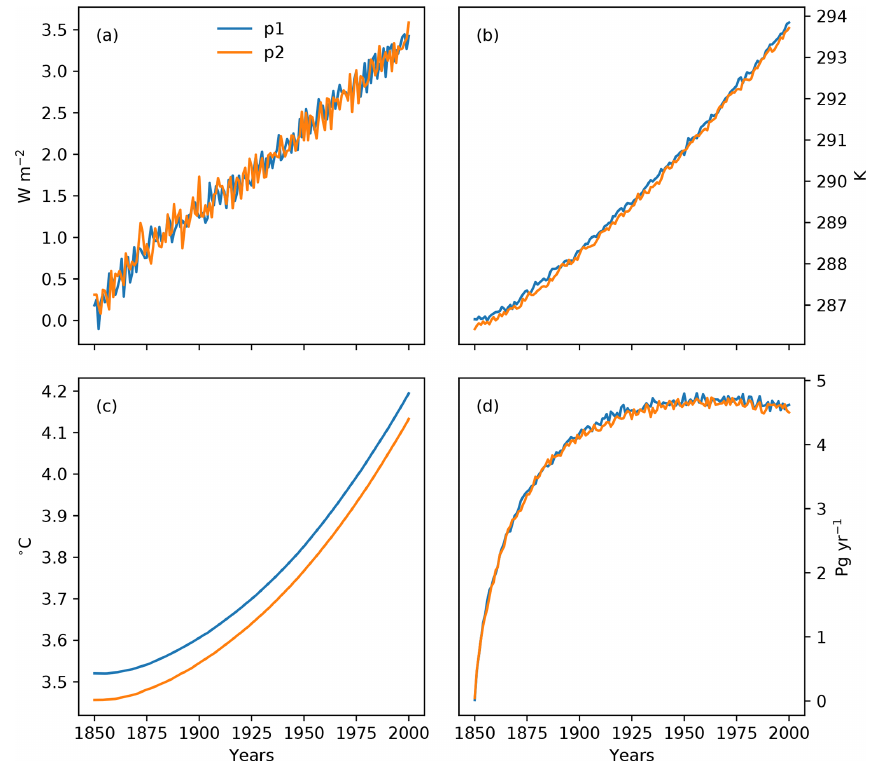
Figure E3. Global averages of (a) top-of-atmosphere net radiative flux, (b) surface air temperature, (c) volume-averaged ocean temperature, and (d) surface ocean CO 2 flux in the 1pctCO2 simulations from the p1 and p2 model